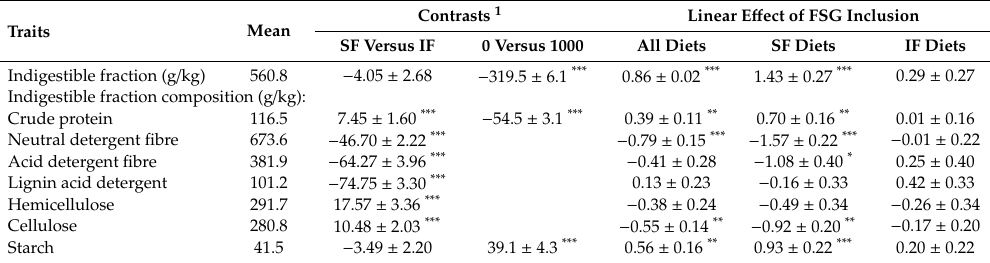
Table 4. E ff ect of fenugreek seed gum (FSG) inclusion in the experimental diets (SF and FI) on the amount and composition of the indigestible fraction after an in vitro enzymatic digestion with pepsin and pancreatin (least square means ± standard error).